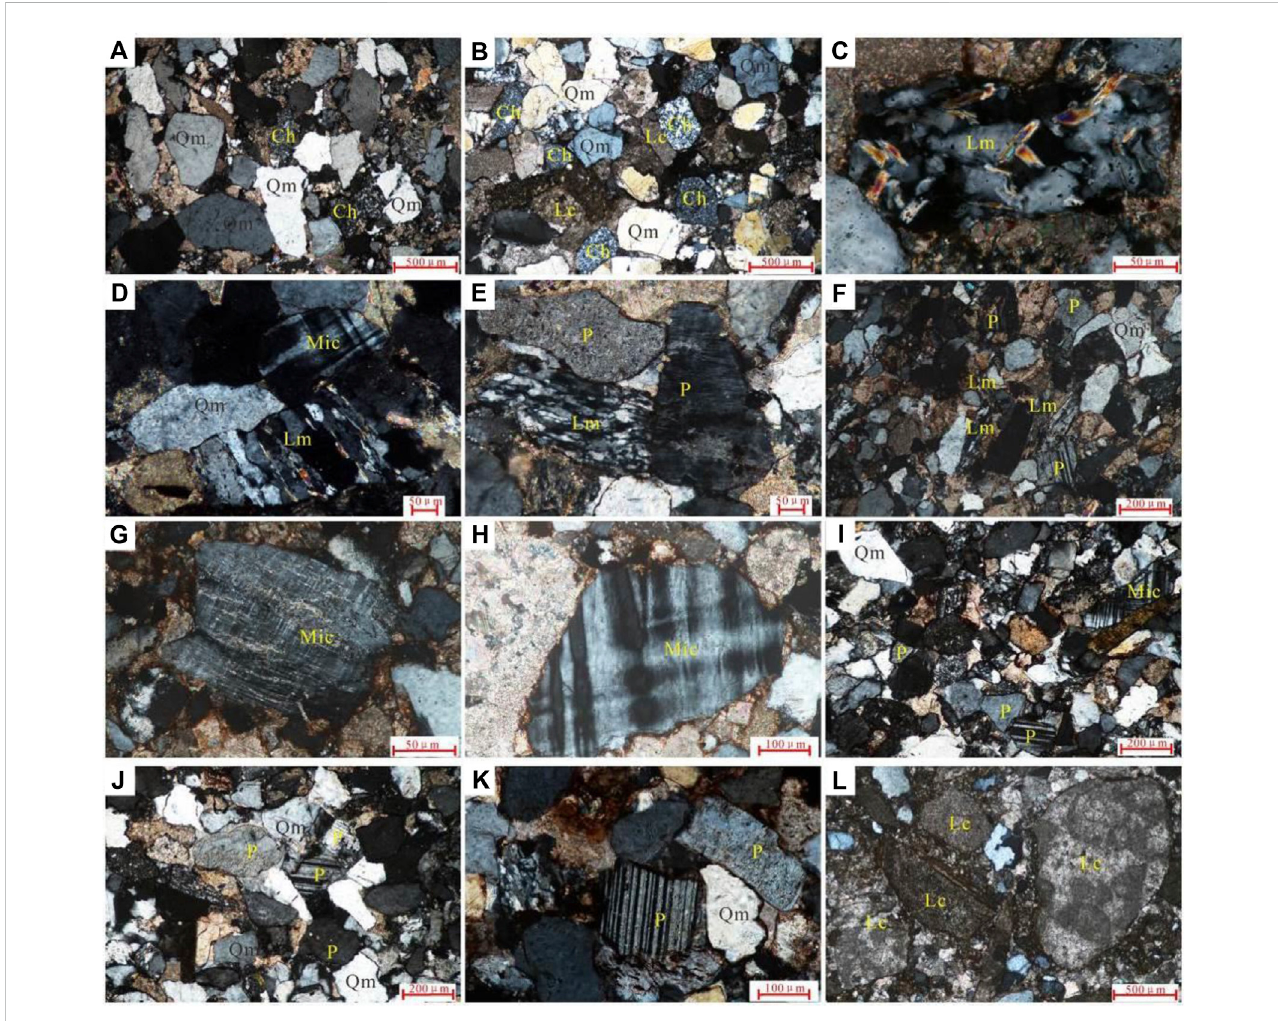
FIGURE 7 Selection of thin section photomicrographs of light minerals (crossed polarized light) in the Tianmashan (A – C) , Jiaguan (D – I) , and Guankou (J – L) Formations. Qm, monocrystalline quartz; Lm, metamorphic lithic; Lc, carbonate lithic; Ch, chert lithic; Mic, microcline; P, plagioclase.